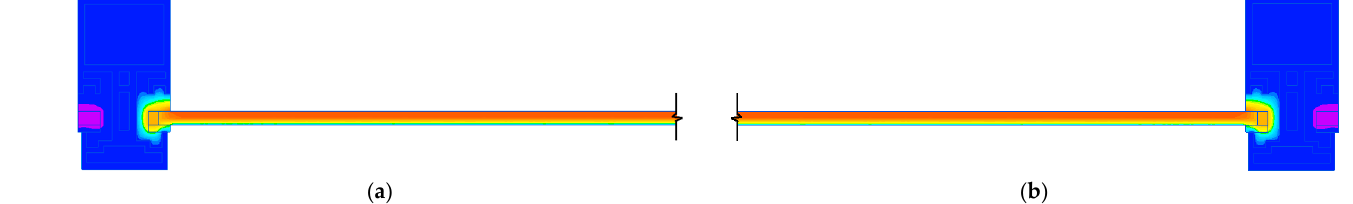
Figure 12. Visualization of the heating of the ( a ) left side and ( b ) right side of the glazing structure of sample No. 2.4.